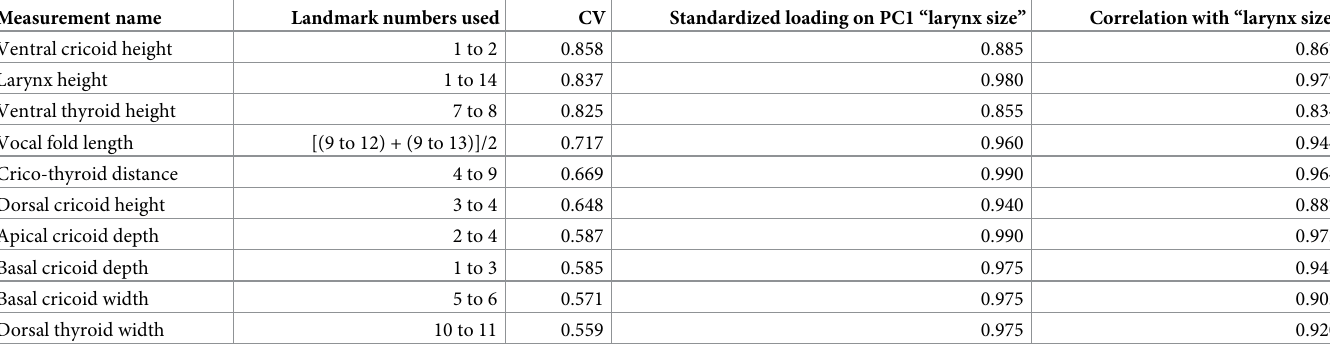
Table 1. Laryngeal measurements sorted from most to least variable by CVs calculated on raw